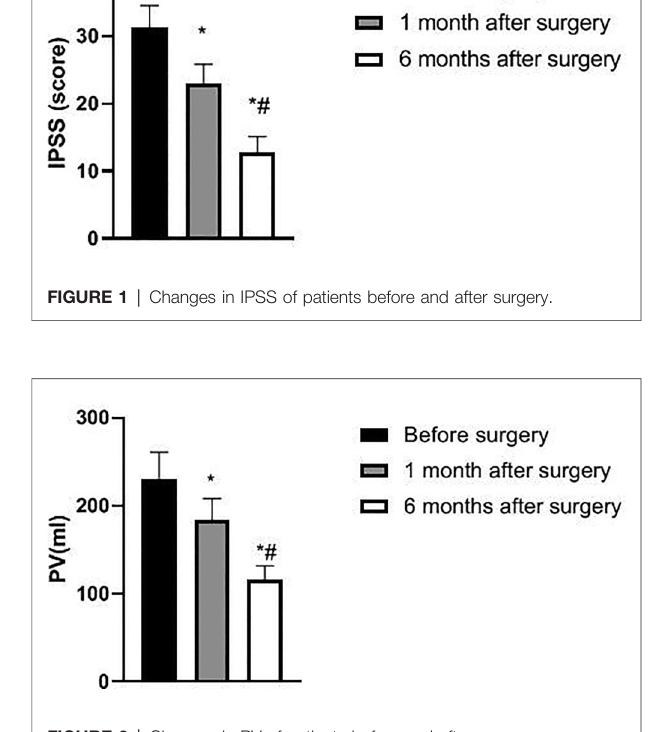
FIGURE 2 | Changes in PV of patients before and after surgery.